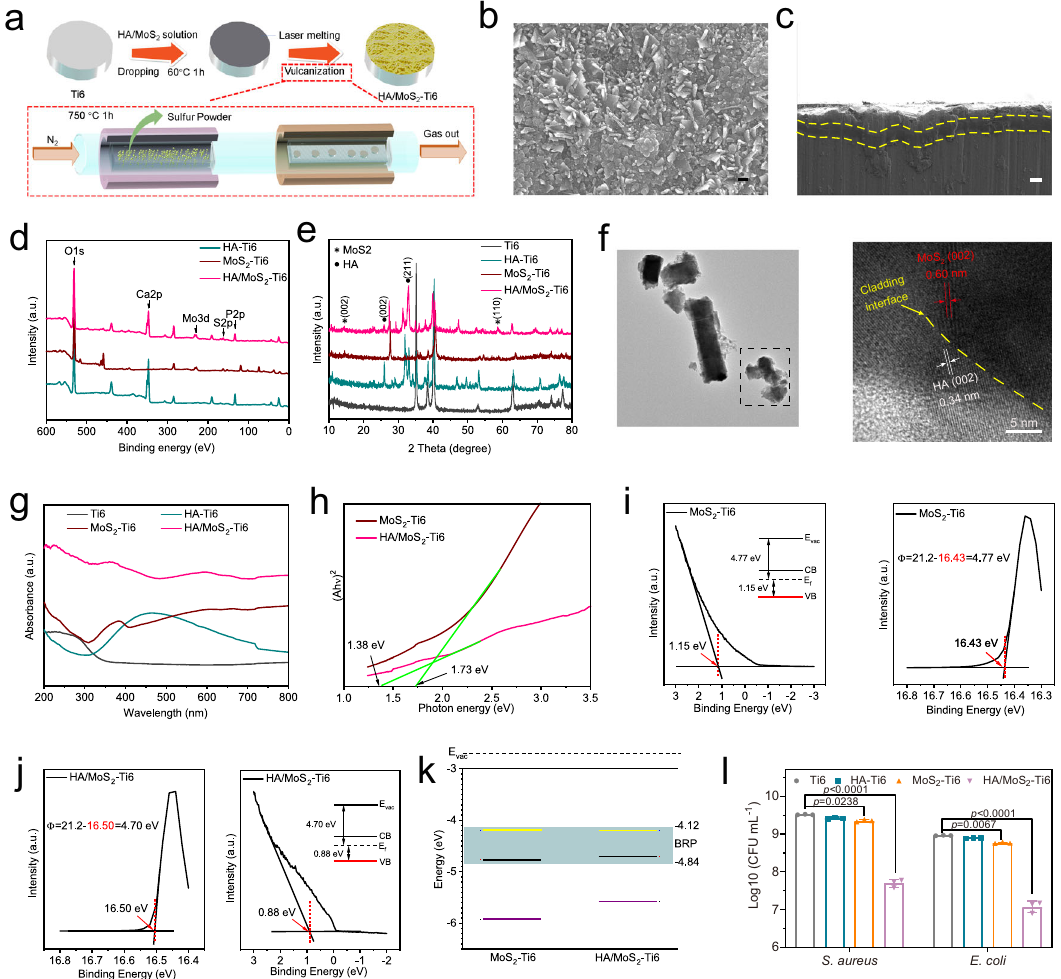
Fig. 2 Characterization and antibacterial performance of HA/MoS 2 -Ti6. a A schematic illustration of the synthesis process of HA/MoS 2 -Ti6. b SEM image of HA/MoS 2 -Ti6 ( n = 3 independent samples) (scale bar = 200 nm). c Cross-section image of HA/MoS 2 -Ti6 ( n = 3 independent samples) (scale bar = 10 μ m). d XPS survey scan of HA – Ti6, MoS 2 -Ti6, and HA/MoS 2 -Ti6. e XRD patterns of Ti6, HA – Ti6, MoS 2 -Ti6, and HA/MoS 2 -Ti6. f TEM image of HA/MoS 2 scraped from HA/MoS 2 -Ti6 (left) (scale bar = 500 nm) and corresponding HRTEM image (right). ( n = 3 independent samples). g UV-Vis-NIR spectra of Ti6, HA – Ti6, MoS 2 -Ti6, and HA/MoS 2 -Ti6. h The corresponding plot analysis of optical bandgap of pristine MoS 2 and HA/MoS 2 . i UPS spectra measured by He I (hv = 21.22 eV) spectra. of the MoS 2 -Ti6. The valence band of MoS 2 -Ti6 (left). The secondary electron cutoff of MoS 2 -Ti6 (right). j UPS spectra measured by He I (hv = 21.22 eV) spectra. The secondary electron cutoff of HA/MoS 2 -Ti6 (left). The valence band of HA/MoS 2 -Ti6 (right). k Energy level diagram of HA/MoS 2 -Ti6 and the representation of electron transfer mechanism to bacterial membrane. Red line, green line, and blue line stands for CB level, VB level, and Fermi level, respectively. And the dark blue area shows the range of BRP (from − 4.12 to − 4.84eV). l The antibacterial results of Ti6, HA – Ti6, MoS 2 -Ti6, and HA/MoS 2 -Ti6 against S. aureus and E. coli . Data represented as mean ± standard deviations from a representative experiment. Error bar represents the standard deviation. p- values were generated by two-way analysis of variance (ANOVA) with Dunnett ’ s multiple comparison test. ( n = 3 independent samples). Source data are provided as a Source Data fi